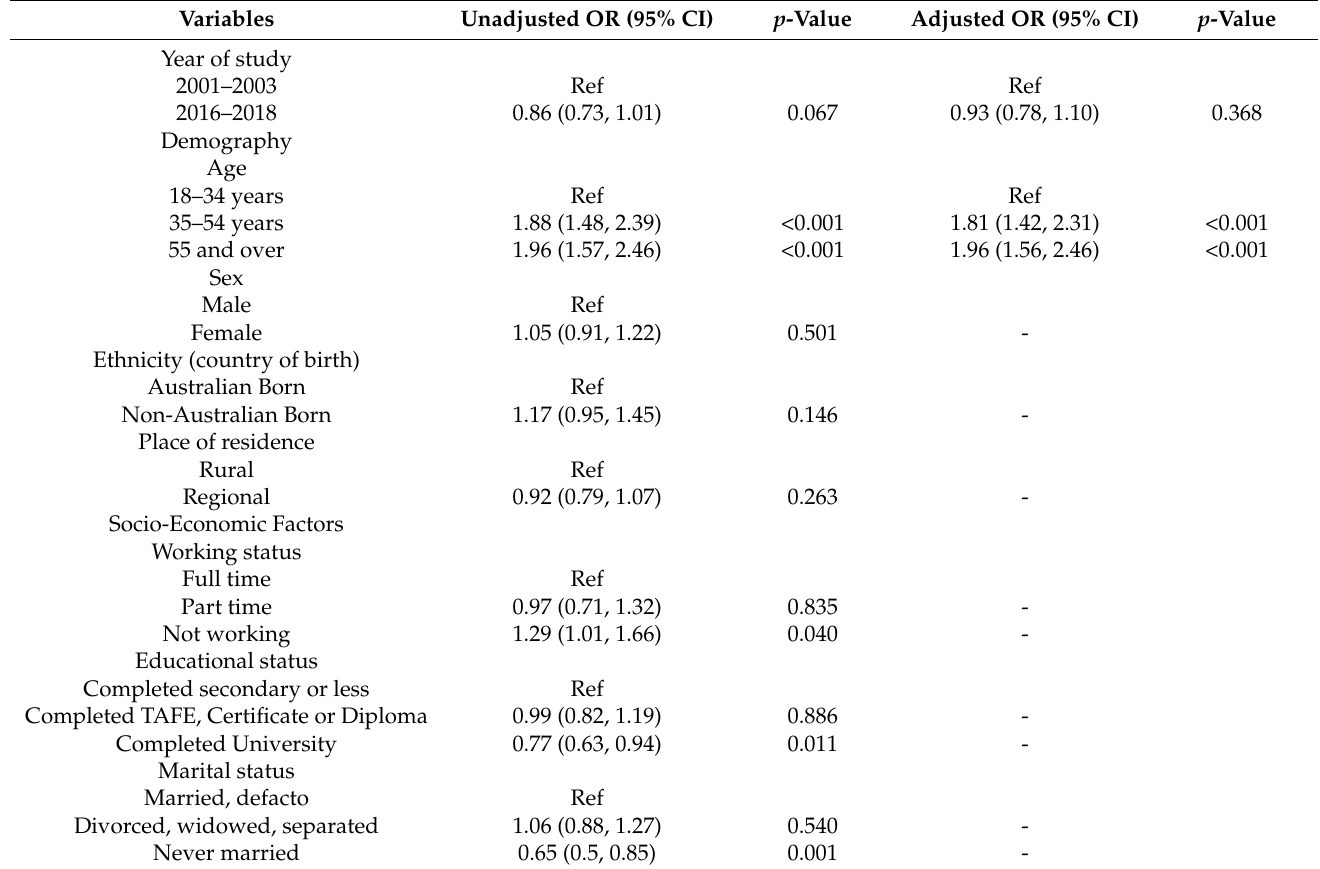
Table 3. Adjusted and unadjusted odd ratios with 95% CI for factors associated with obesity in regional Victoria (Crossroads studies 2001–2003 and 2015–2018). TAFE = Technical and Further